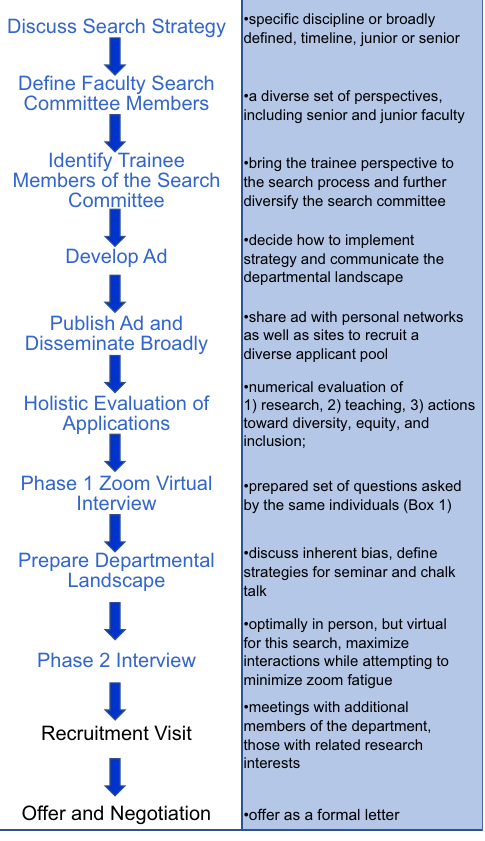
Fig. 1 An overview of the faculty search process. All steps depicted in blue were modi fi ed to some extent to achieve the goal of having an inclusive faculty search process. Each of the steps modi fi ed in this search is addressed in detail in the